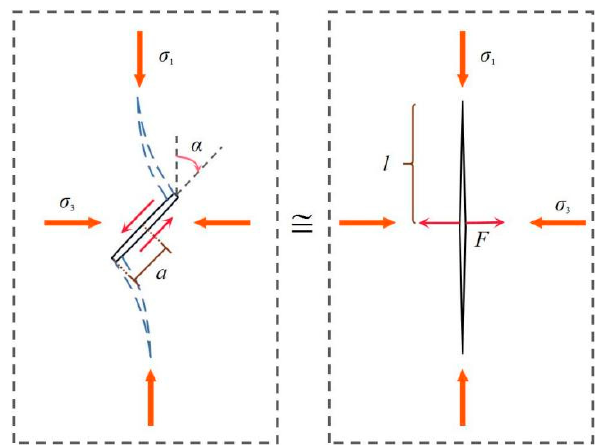
Figure 12. Approximation of an inclined crack with wing cracks by a straight crack with a concen- trated force at the center.